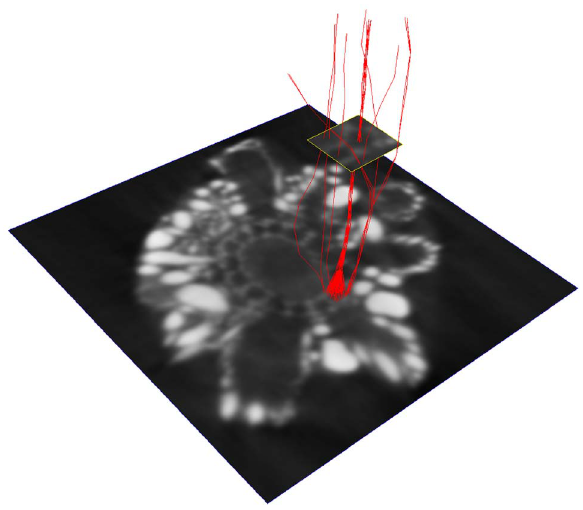
Figure 14. Example of pathways converging from various initialization points. Only a small subset of pathways initialized beyond the canal lumen did not converge.